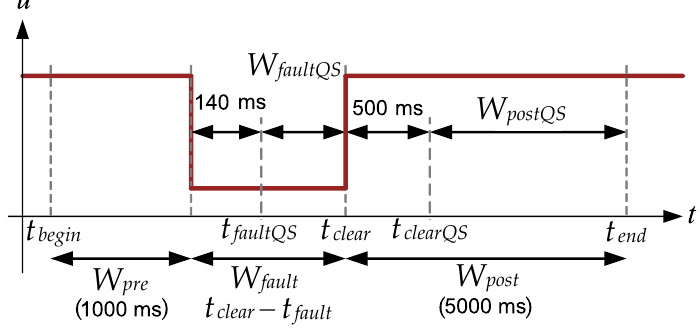
Figure 2. Voltage dip windows adapted from